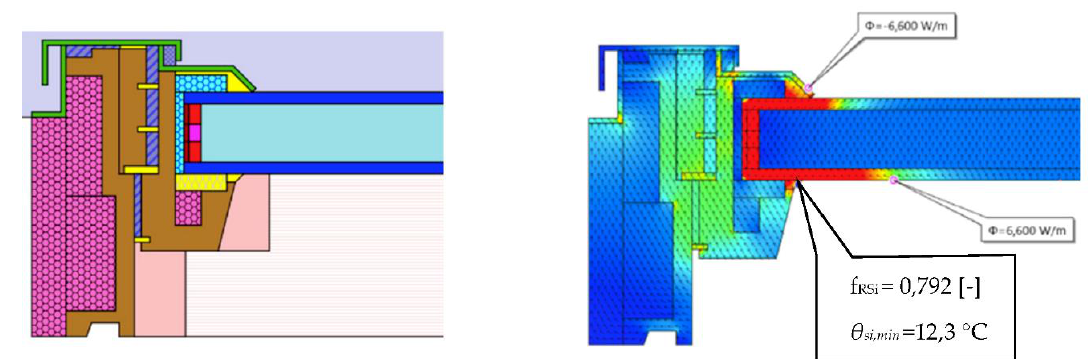
Figure 14. Schematic cross-section of the window variant, II , with special glazing using two foils to divide the cavity between two glazing panes ( left ) and calculated heat flux distribution ( right ).